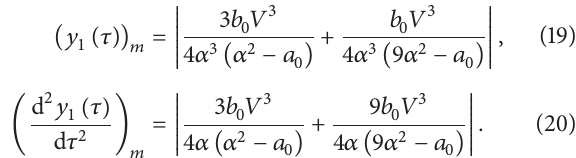
Figure 2: Comparison of the nondimensional displacement 𝑦 -time 𝜏 responseofthesystembytheVIMwiththeonebytheRunge-Kutta (ODE45) method when the suspension angle 𝜙 0 = 60 ∘ .